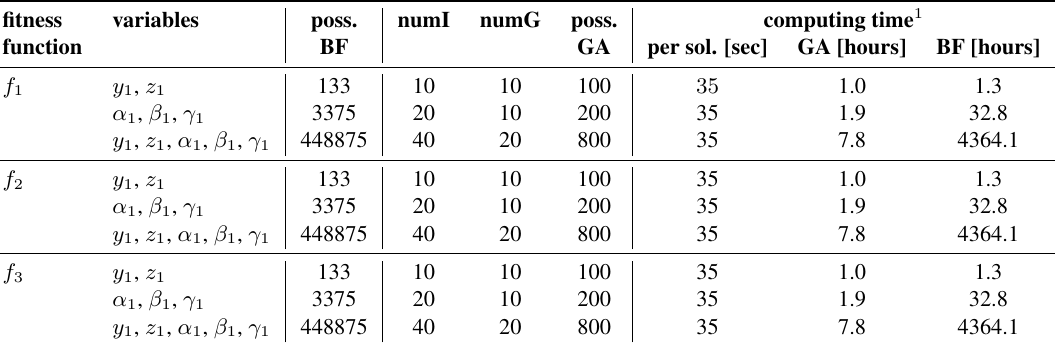
Table 5. Results of a separate optimisation of the RP translations